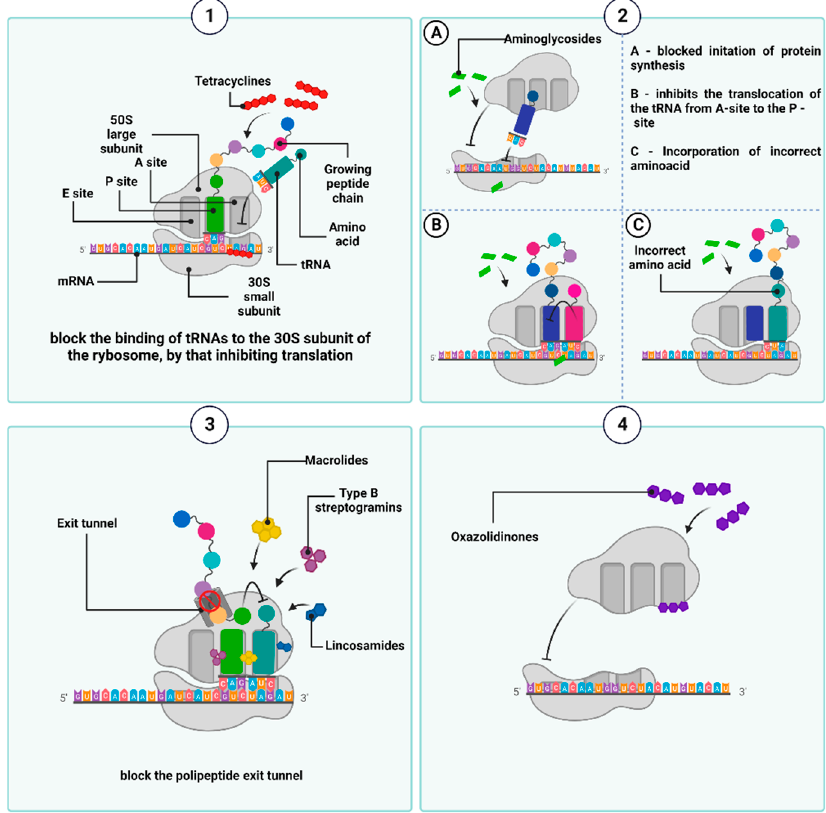
Figure 5. Mechanism of action of ( 1 ) tetracyclines; ( 2 ) aminoglycosides; ( 3 ) MLSB macrolides, lincosamides, and type B streptogramins; ( 4 ) oxazolidinones. Figure created with Biorender.com.